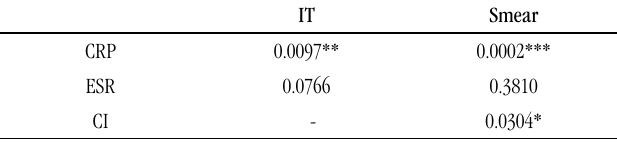
tABLE 3 – Comparison of p -value between CRP, ESR versus the severity of CI and smear at T0, by non-parametric ANOVA method IT Smear